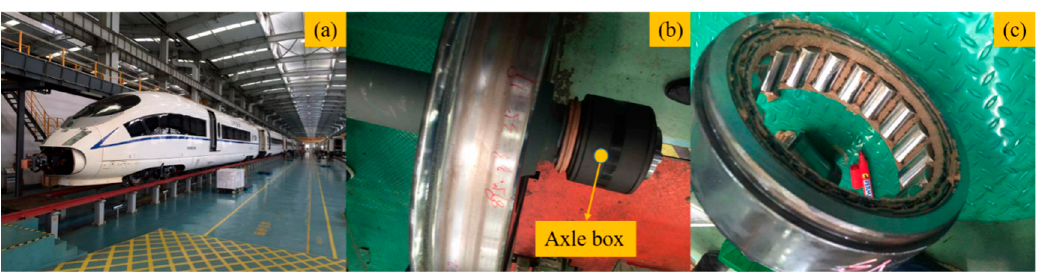
Figure 1. ( a ) A CRH380B high-speed EMU (electric multiple unit) under maintenance. ( b ) Installation position of axle box bearing on wheelset that was removed from the train. ( c ) A disassembled faulty axle box bearing.